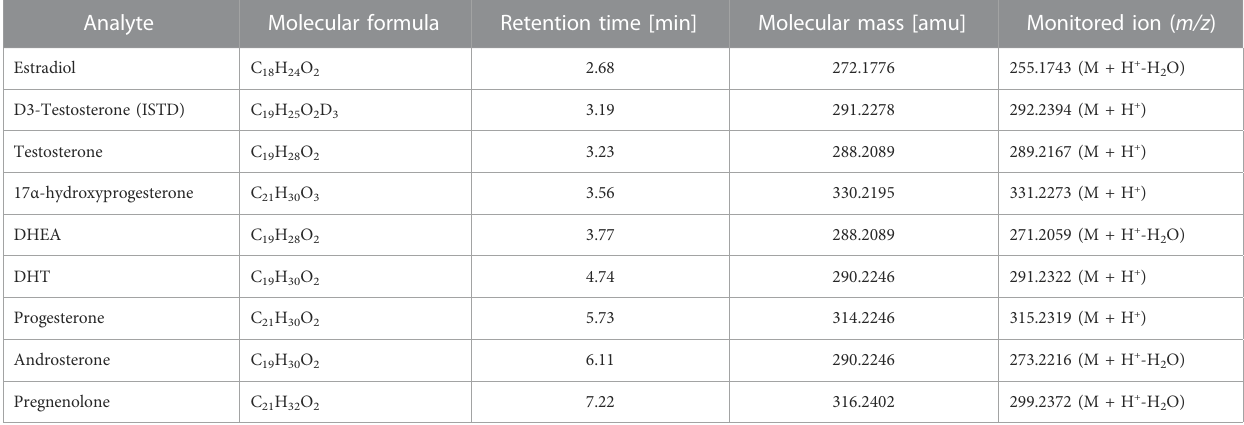
TABLE 1 The characteristics of detected steroid hormones including their molecular formula, mass, retention time and m/z of monitored ion.